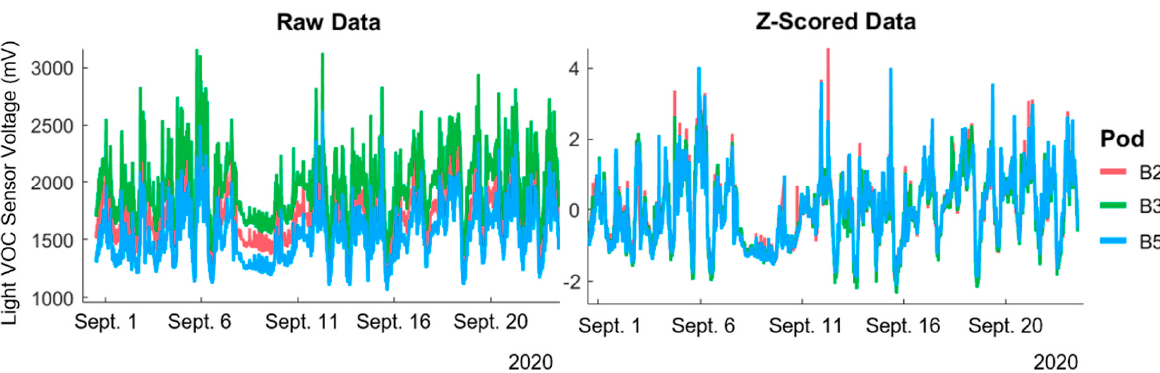
Figure 3. Light VOC metal oxide co-location sensor readings in their raw format ( left ) and after being z-scored ( right ).